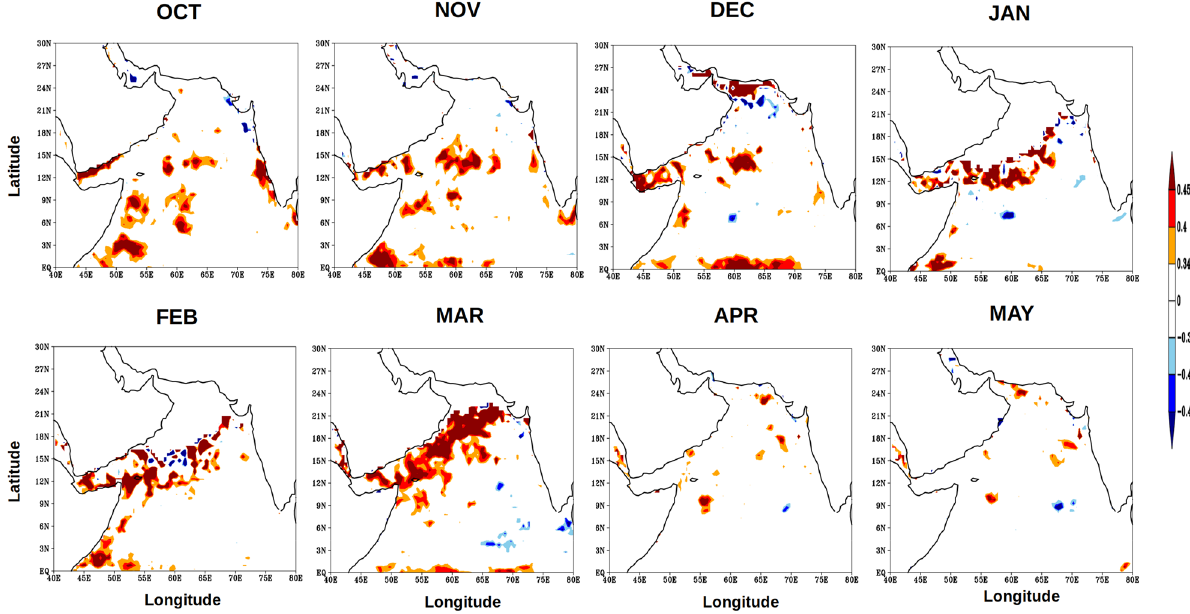
Figure 7. Monthly anomaly correlation of wind stress curl over the box region (50–70°E and 4–12°N, see Fig. 1) with UOHC of the Arabian Sea from October to May for the period of 1980–2015. The red colour represent the positive correlation value and the blue colour represents the negative correlation value, both significant at 95% confidence.